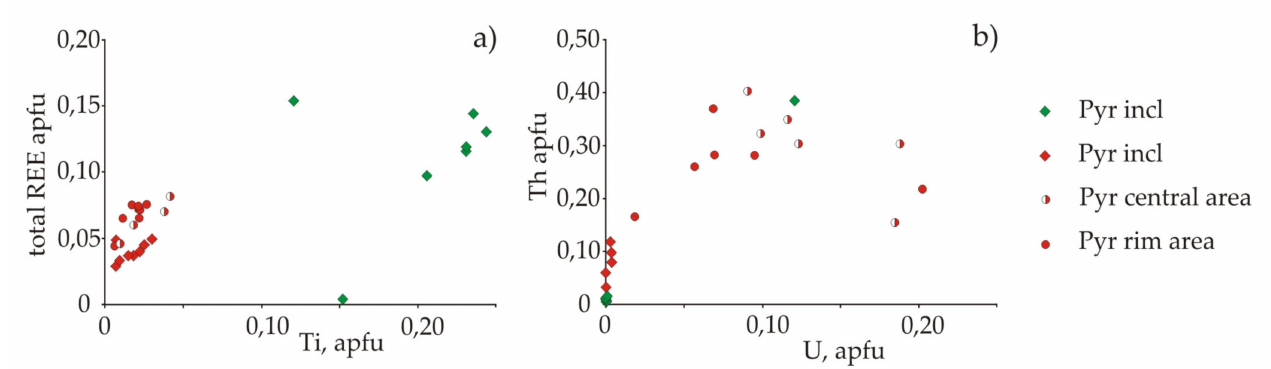
Figure 9. Variation of pyrochlore compositions from Arbrastakh phoscorites ( a ) Ba; ( b ) F vs. Ca.